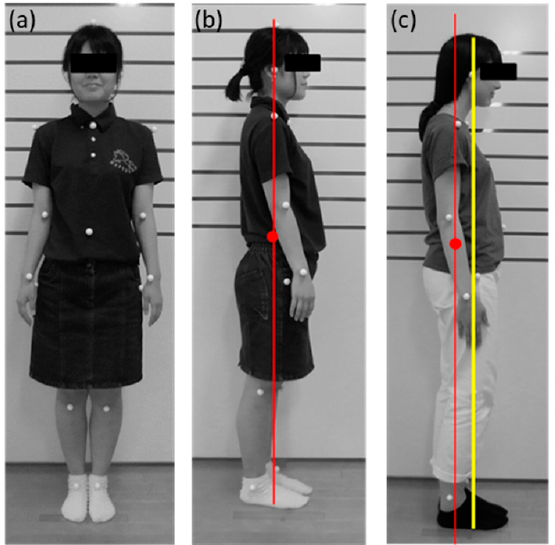
Figure 1. Standing posture. Coronal plane ( a ) and Sagittal plane (ideal ( b ) and forward lean posture ( c )).